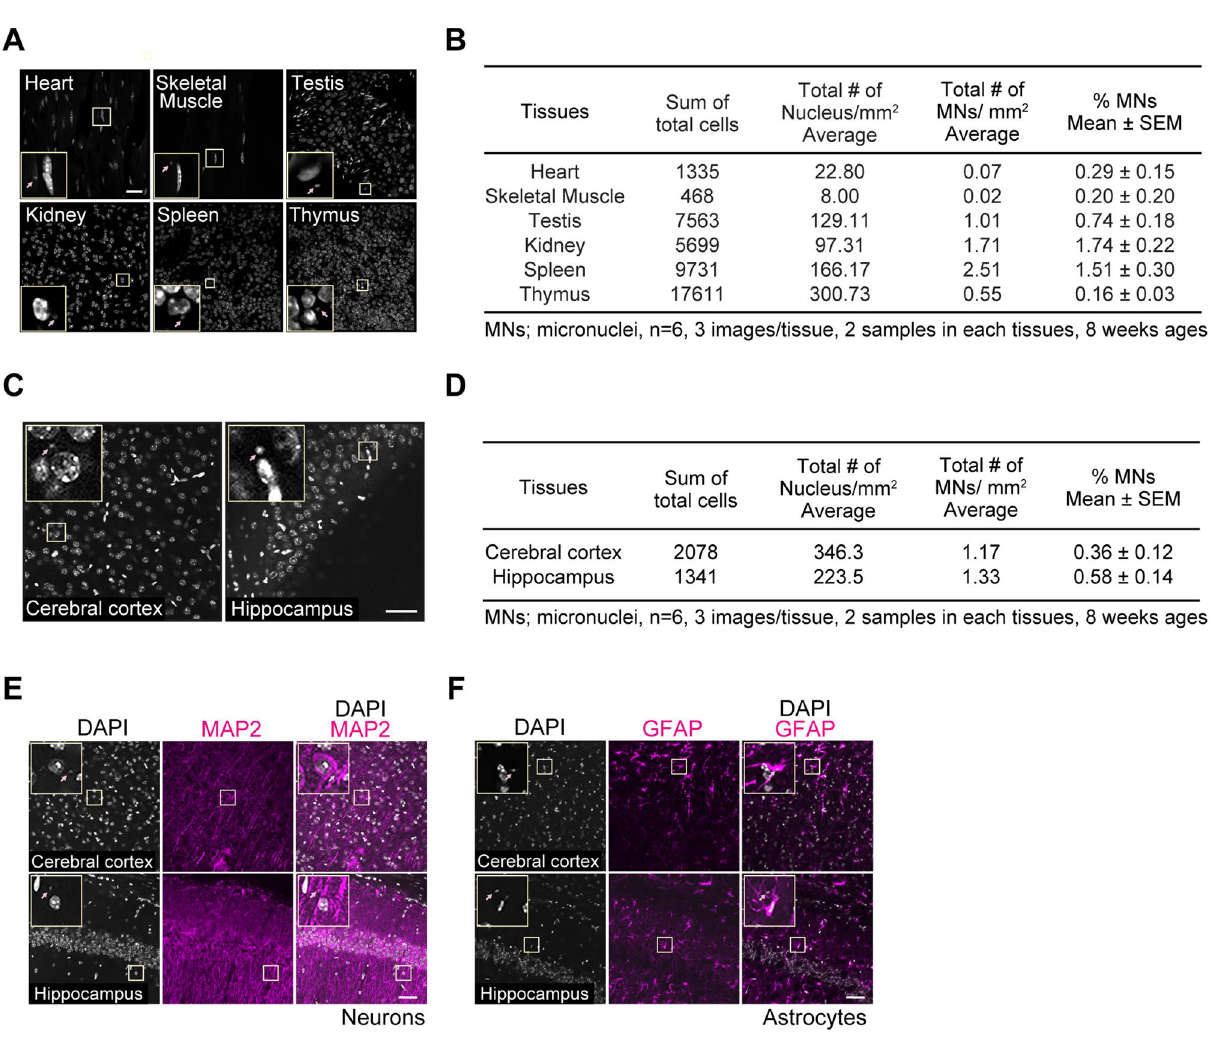
Figure 1. Micronuclei emerge in various tissues of adult mice. ( A ) Nuclei in each tissue (heart, skeletal muscle, testis, kidney, spleen, thymus) from 2-month-old mice were stained with Hoechst 33,342. Insets show an enlargement of the micronuclei in the boxed area. Arrows indicate micronuclei. Scale bar: 50 μm. ( B ) Table shows the quantification of micronuclei in Fig. 1A by human observers. The small nucleus-like structure, which is approximately less than 2.0 μm, was counted as a micronucleus. The three images were obtained from the tissue sections prepared from a single mouse. The other three images were obtained from an alternate mouse (a total of 6 images from 2 mice brains). ( C ) Nuclei in the brain (cerebral cortex and hippocampus) from 2-month-old mice were stained with DAPI. Insets show an enlargement of the micronuclei in the boxed area. Arrows indicate micronuclei. Scale bar: 50 μm. ( D ) Table shows the quantification of micronuclei in Fig. 1C by human observers. The small nucleus-like structure, which is approximately less than 2.0 μm, was counted as a micronucleus. The three images were obtained from the tissue sections prepared from a single mouse. The other three images were obtained from an alternate mouse (a total of 6 images from 2 mice brains). ( E ) Immunostaining of MAP2 in the cerebral cortex and hippocampus of 2-month-old mice. Insets show an enlargement of the micronuclei in the boxed area. Arrows indicate micronuclei. Scale bar: 50 μm. ( F ) Immunostaining of GFAP in the cerebral cortex and hippocampus of 2-month-old mice. Insets show an enlargement of the micronuclei in the boxed area. Arrows indicate micronuclei. Scale bar: 50 μm. Adobe Creative Could CC (Photoshop 22.1.0 and Illustrator 25.0.1) (https:// www. adobe. com/) and FIJI Image J 2.1.0/1.53c (https:// imagej. nih. gov/ ij/) were used for all image processing in Fig.